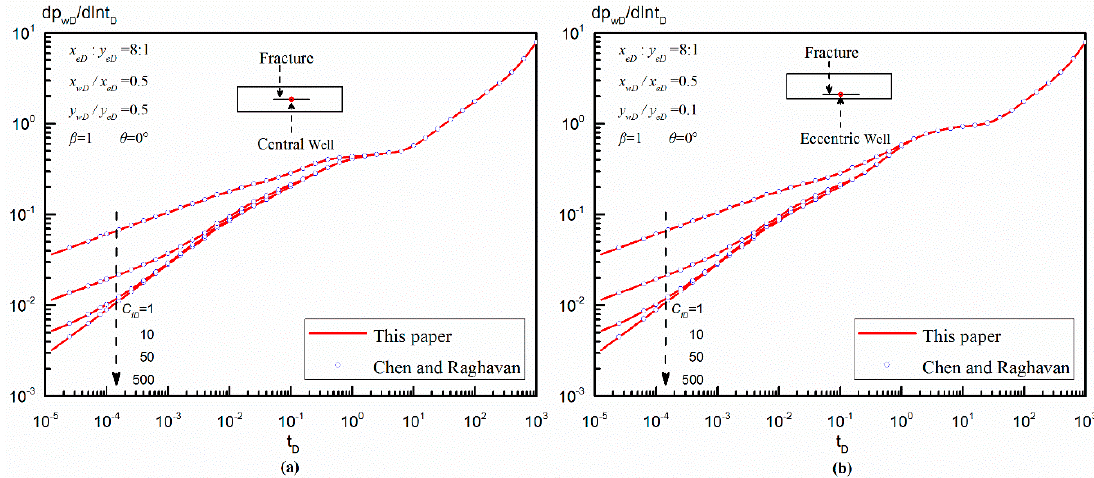
Figure 3. Validation of a fractured well located at different positions in an anisotropic rectangular reservoir. ( a ) central well; ( b ) eccentric well.